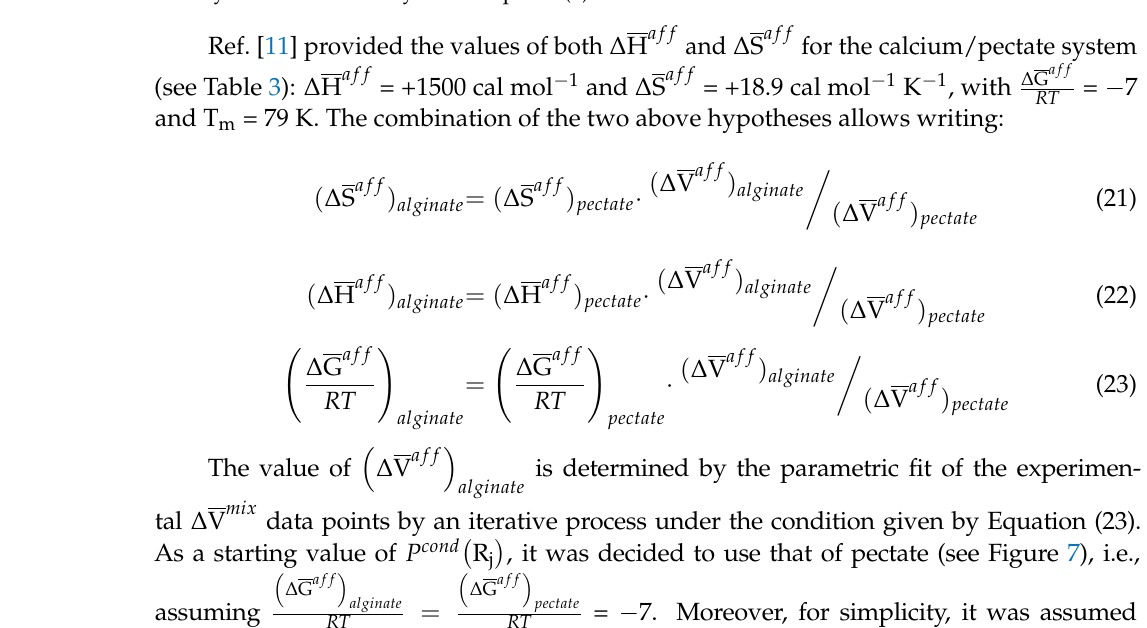
Figure 8. ( a ) Barclay–Butler plot— ∆ H af f vs. ∆ S af f —for different polyuronates interacting with Mg 2+ ions (black open squares) and with Ca 2+ (full red squares); ( b ) reduced Gibbs free-energy of affinity for the different systems of panel ( a ).